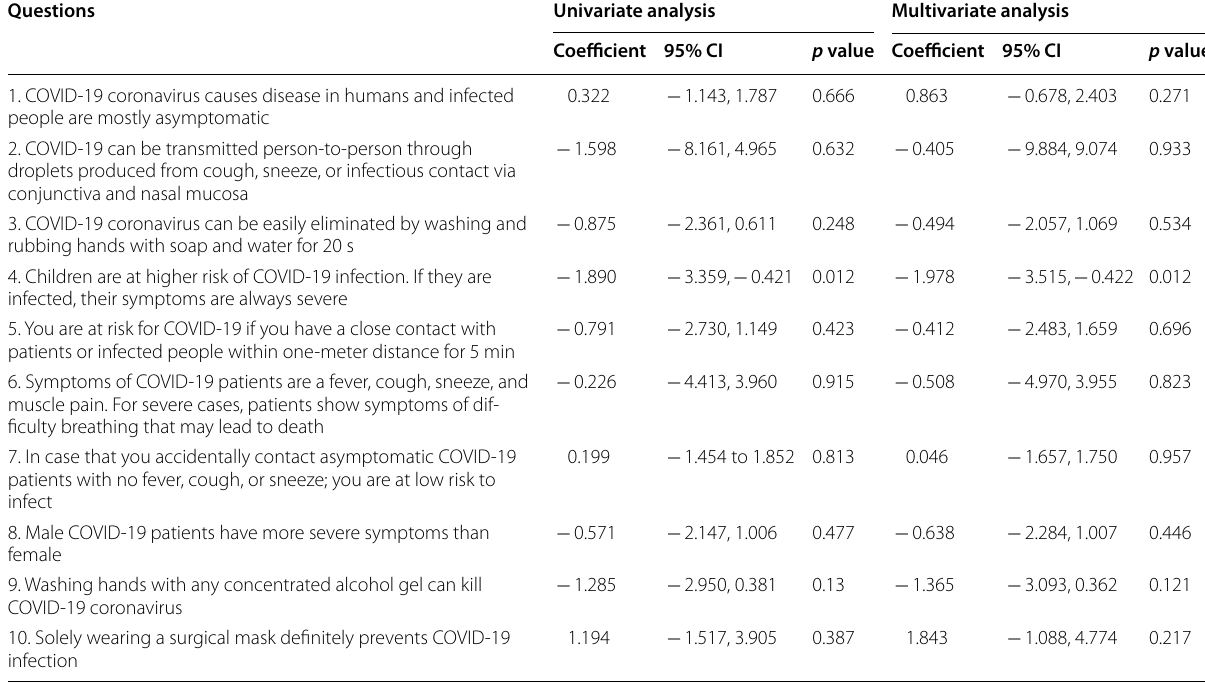
CI confidence interval